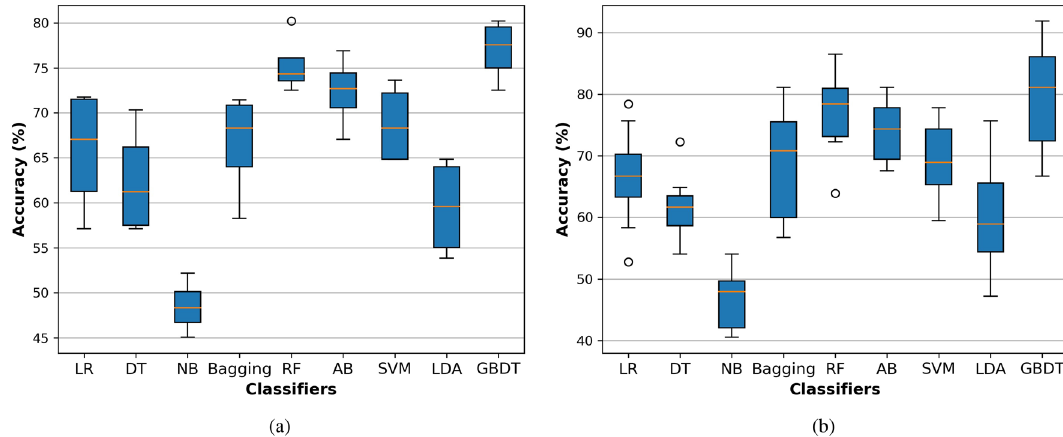
Figure 4. The AUC for the proposed system based on the GBDT compared with state-of-the-art classifiers on the protein dataset with ( a ) 4-fold and ( b ) 10-fold cross-validation techniques.